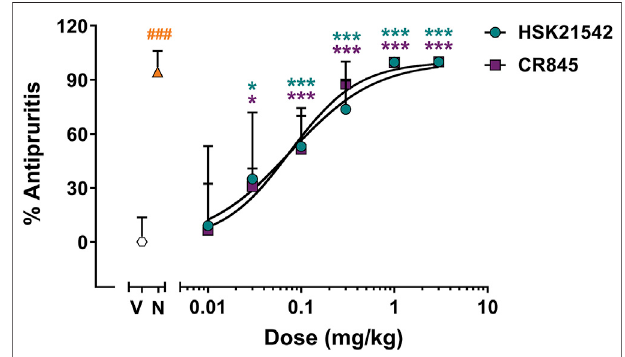
FIGURE 5 | Antipruritic effects of HSK21542 and CR845 in compound 48/80-induceditchmodel. Dataarepresented asmeans ± SD( n (cid:1) 10/group). * p < 0.05, *** p < 0.001 vs. vehicle, one-way ANOVA followed by Dunnett ’ s test; ### p < 0.001 vs. vehicle, Mann-Whitney test. V, Vehicle; N, Nalfura fi ne (0.02 mg/kg, a positive